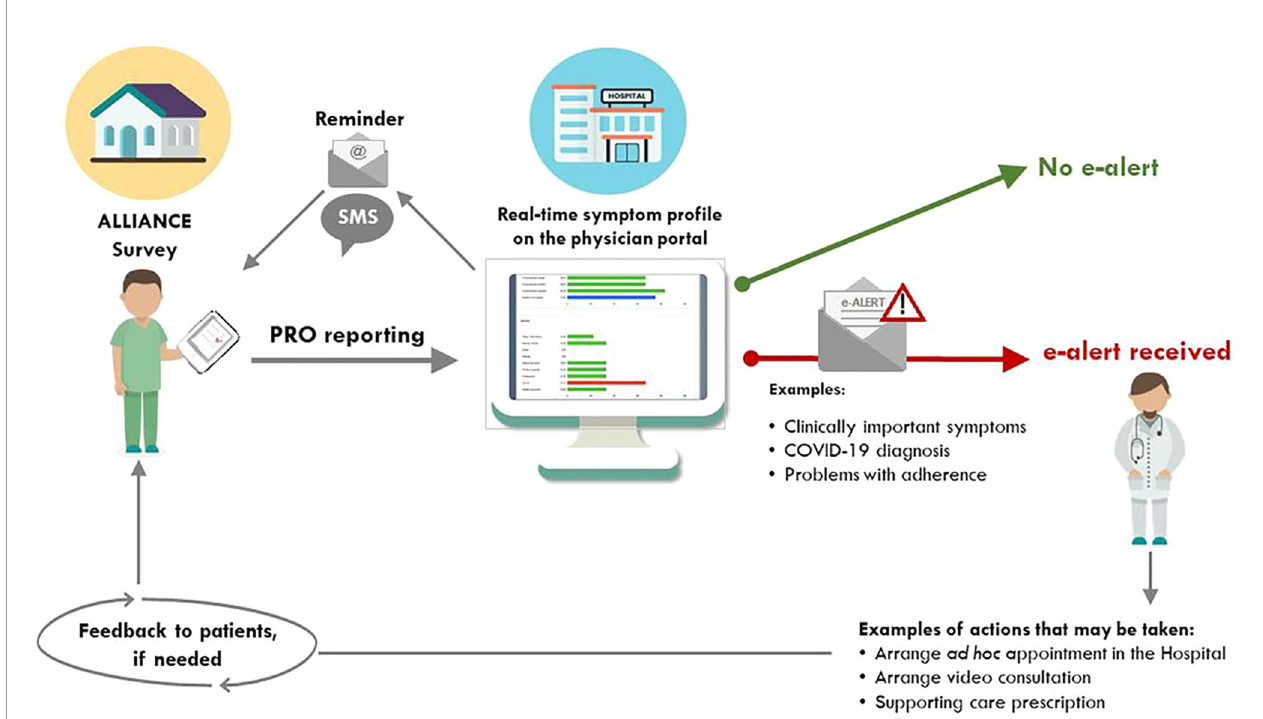
FIGURE 1 | Schematic work fl ow of the patient-generated alerts to the medical team. PRO, patient-reported outcomes. This Figure was fi rst published under the terms of the Creative Commons Attribution License (https://creativecommons.org/licenses/by/4.0/) in JMIR Research Protocols: Ef fi cace F, Breccia M, Fazi P, Cottone F, Holzner B, Vignetti M. The GIMEMA-ALLIANCE Digital Health Platform for Patients With Hematologic Malignancies in the COVID-19 Pandemic and Postpandemic Era: Protocol for a Multicenter, Prospective, Observational Study JMIR Res Protoc 2021;10(6):e25271 (21). URL: https://www.researchprotocols.org/